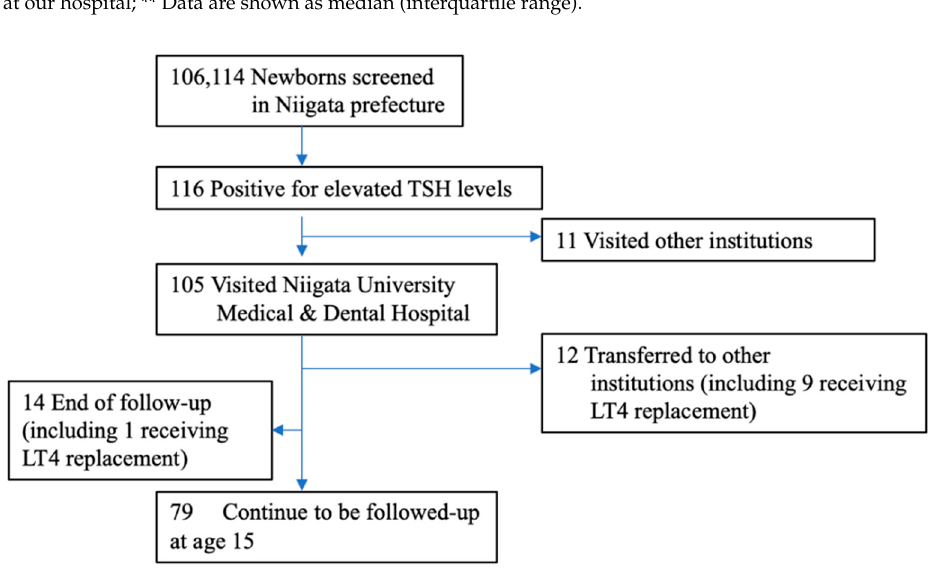
Figure 1. Enrollment of the study subjects. Between April 2002 and March 2006, a total of 106,114 newborns were screened for CH in Niigata prefecture, and 116 were referred to pediatric endocrinologists. We evaluated 105 subjects (90.5%). Eleven patients did not visit our hospital due to reasons such as hospitalization in the neonatal intensive care unit. Fourteen patients (including 1 patient who died after cardiac surgery while on LT4 replacement) with normal thyroid function at the first visit, transient hypothyroidism, or transient hyperthyrotropinemia did not receive further follow-up. Twelve patients, including 9 on LT4 replacement, were transferred to another hospital. At the age of 15, 79 patients were being followed